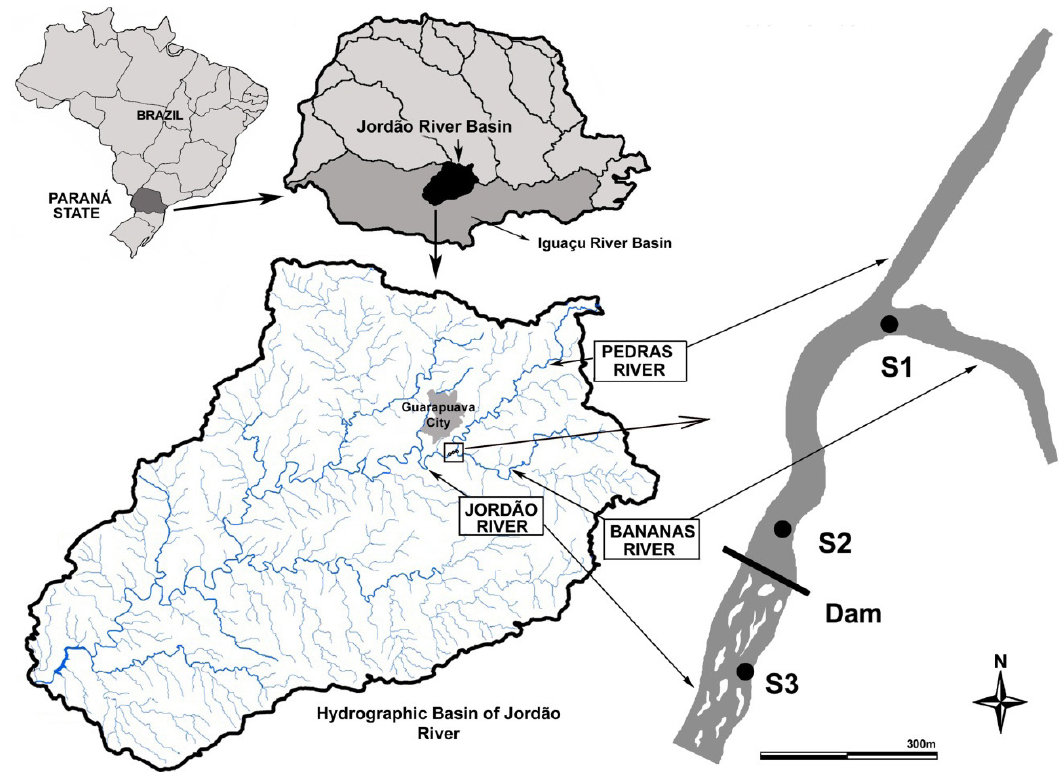
Figure 1. Map of Jordão River basin location and the sampling sites in the Paraná State,